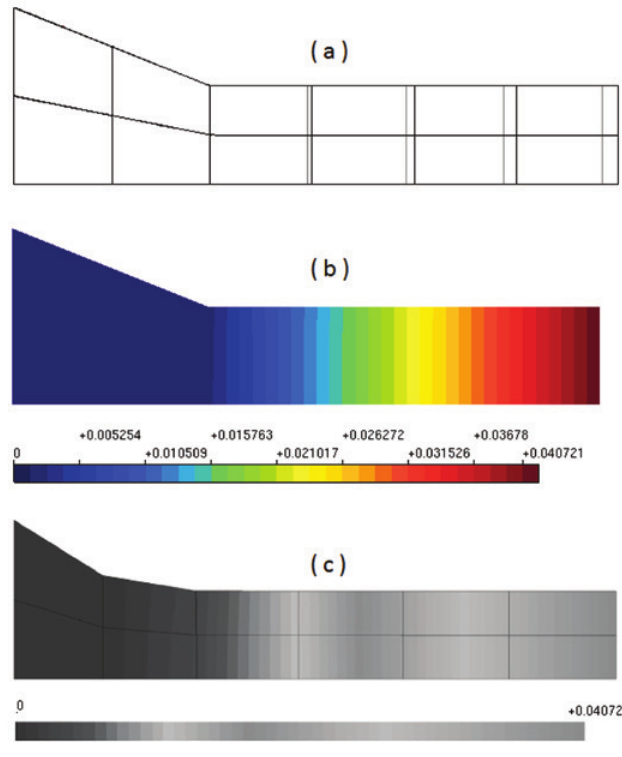
Figure 12 Dogbone-shaped panel – (a) Deformed mesh, (b) displacement field obtained with Ottosen Model and (c) numerical results of PEREIRA et. al